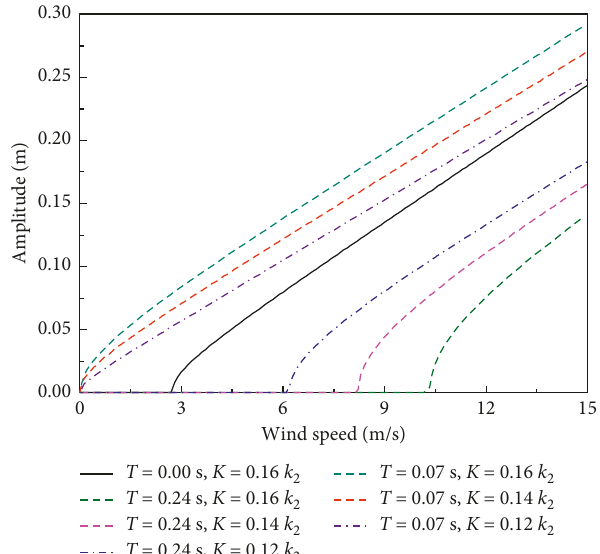
Figure 8: Variation of vibration amplitude of m 2 with wind speed under different time-delay parameters T and strength parameters K .